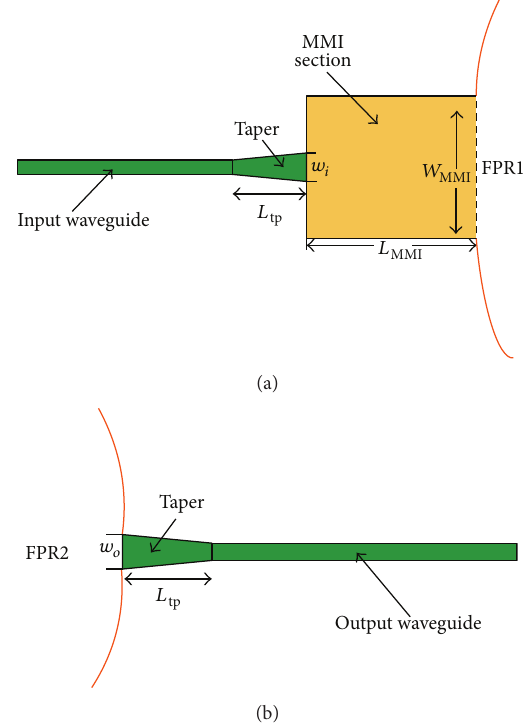
Figure 13: Structure used to flatten spectral responses: (a) section between the input waveguide and FPR1 and (b) section between the output waveguide and FPR2.